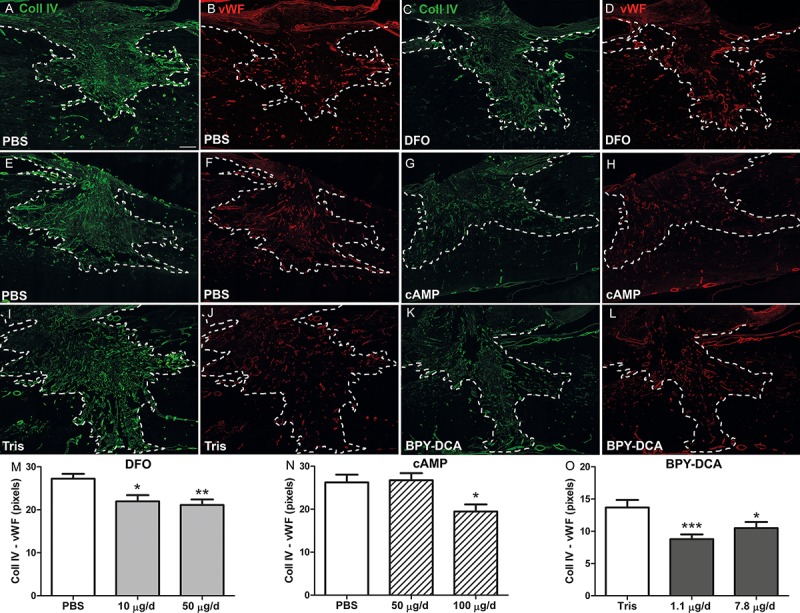
Reduction of scar density measured by the quantification of ECM Coll IV.Mosaic composite pictures of the complete scar in spinal cord injured animals after treatment with (A, B) PBS corresponding to (C, D) DFO treatment, (E, F) PBS corresponding to (G, H) cAMP treatment and (I, J) Tris corresponding to (K, L) BPY-DCA treatment. The tissue was stained for Coll IV in green (A, C, E, G, I, K) and vWF in red (B, D, F, H, J, L). Quantification of ECM Coll IV was performed by subtraction of vWF-positive blood vessels. The remaining signals for ECM Coll IV for the respective treatments were plotted in M, N and O. A significant reduction of Coll IV was observed in both treatment concentrations for BPY-DCA and DFO as well as in the highest concentration of cAMP. High magnification pictures of the Coll IV staining in part of the lesion site are provided in S2 Fig. Statistics: one way Anova with Dunnett’s post-hoc test * p < 0.05, ** p < 0.01, *** p< 0.001 Scale bar (in A) = 200 μm, applies for all pictures.